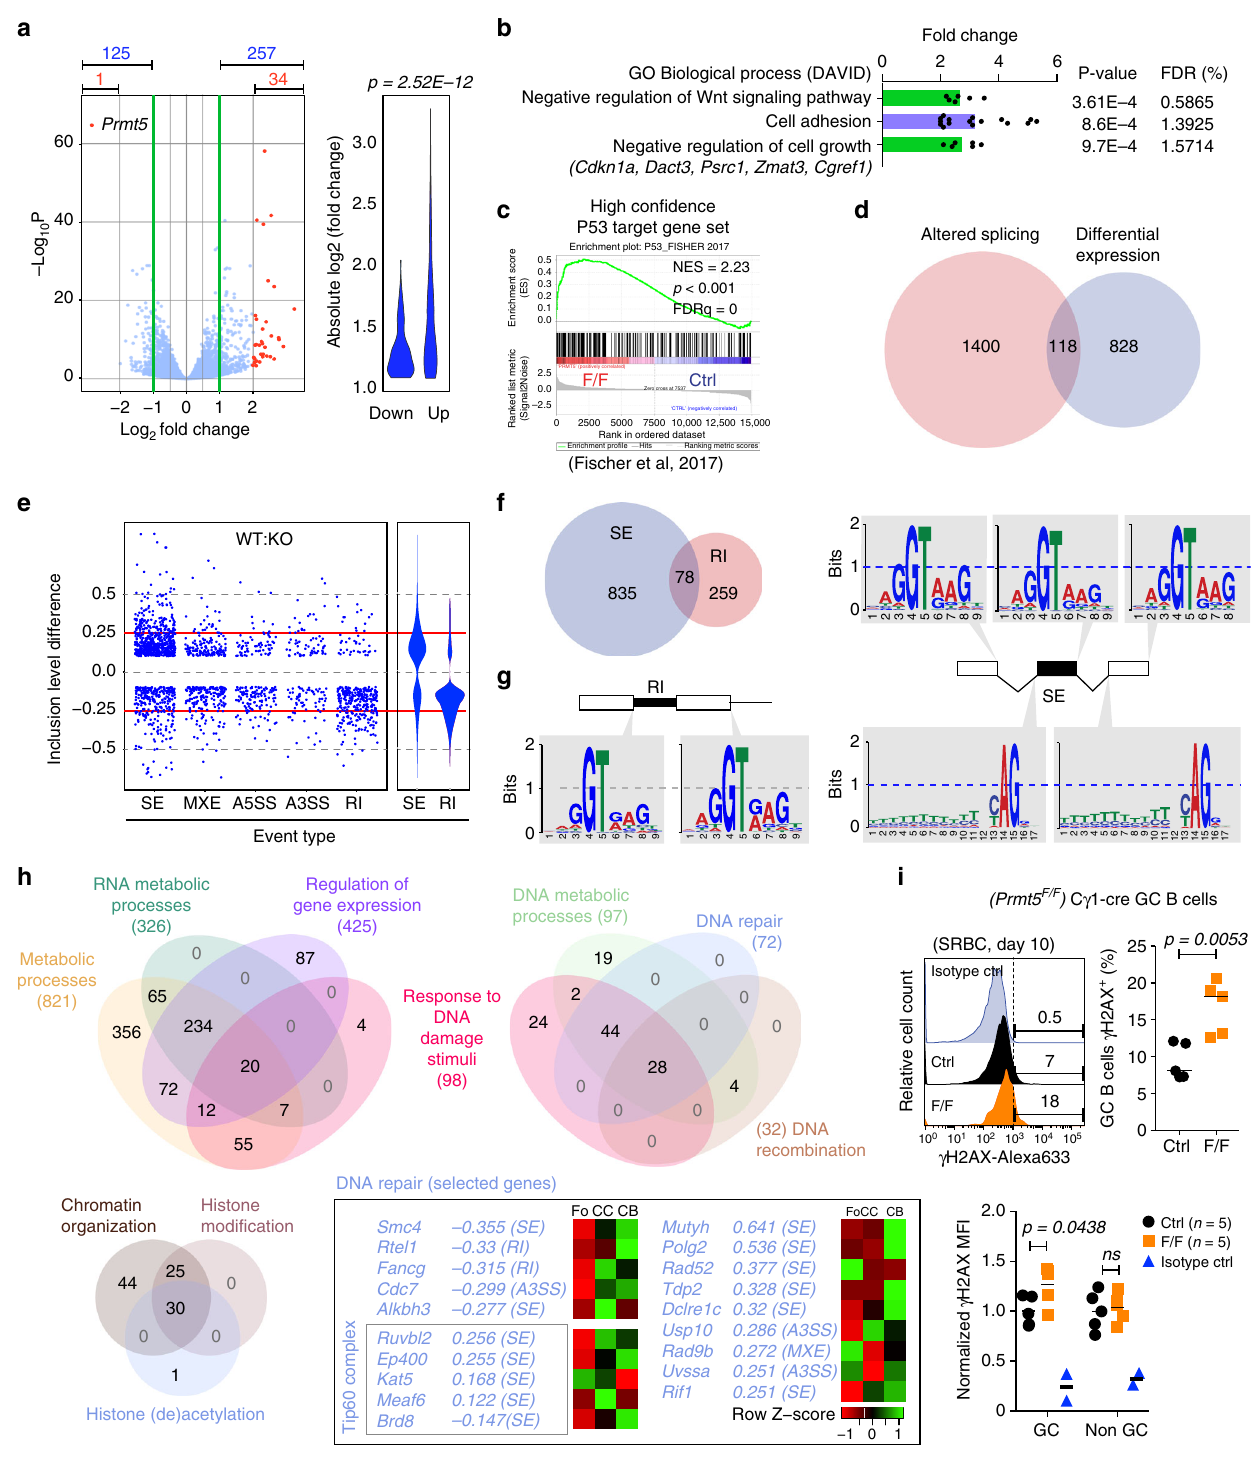
performed RNA-seq for mechanistic insight into the defects of Prmt5-de fi cient B cells. Given the paucity of GC B cells in vivo, we used Prmt5 F/F C γ 1-cre and C γ 1-cre iGBs at day 4 after